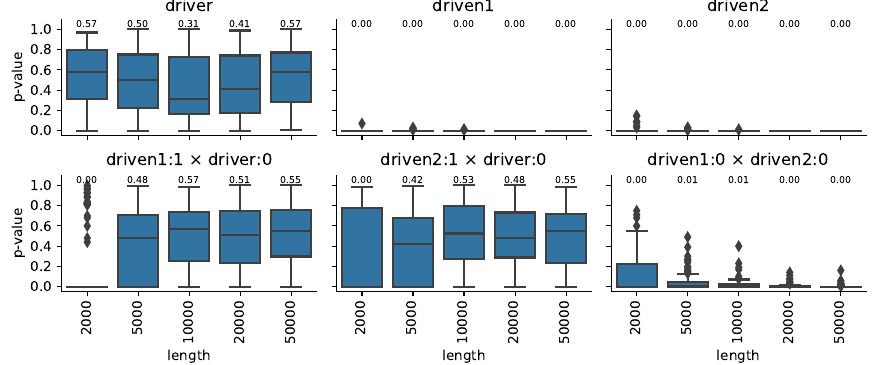
Figure 4. Markov property of the coupled logistic systems with fixed σ = 0.02 noise. The final p -values of the independence test for the single processes in the upper row, for the joint processes in the lower one for different sample sizes. After the colon symbol, the lag is indicated, and the symbol stands for the joint of the two series. The number over the boxes indicates the median value.